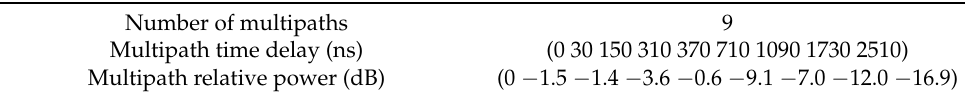
Table 3. Channel parameters of extended vehicular A (EVA) model.